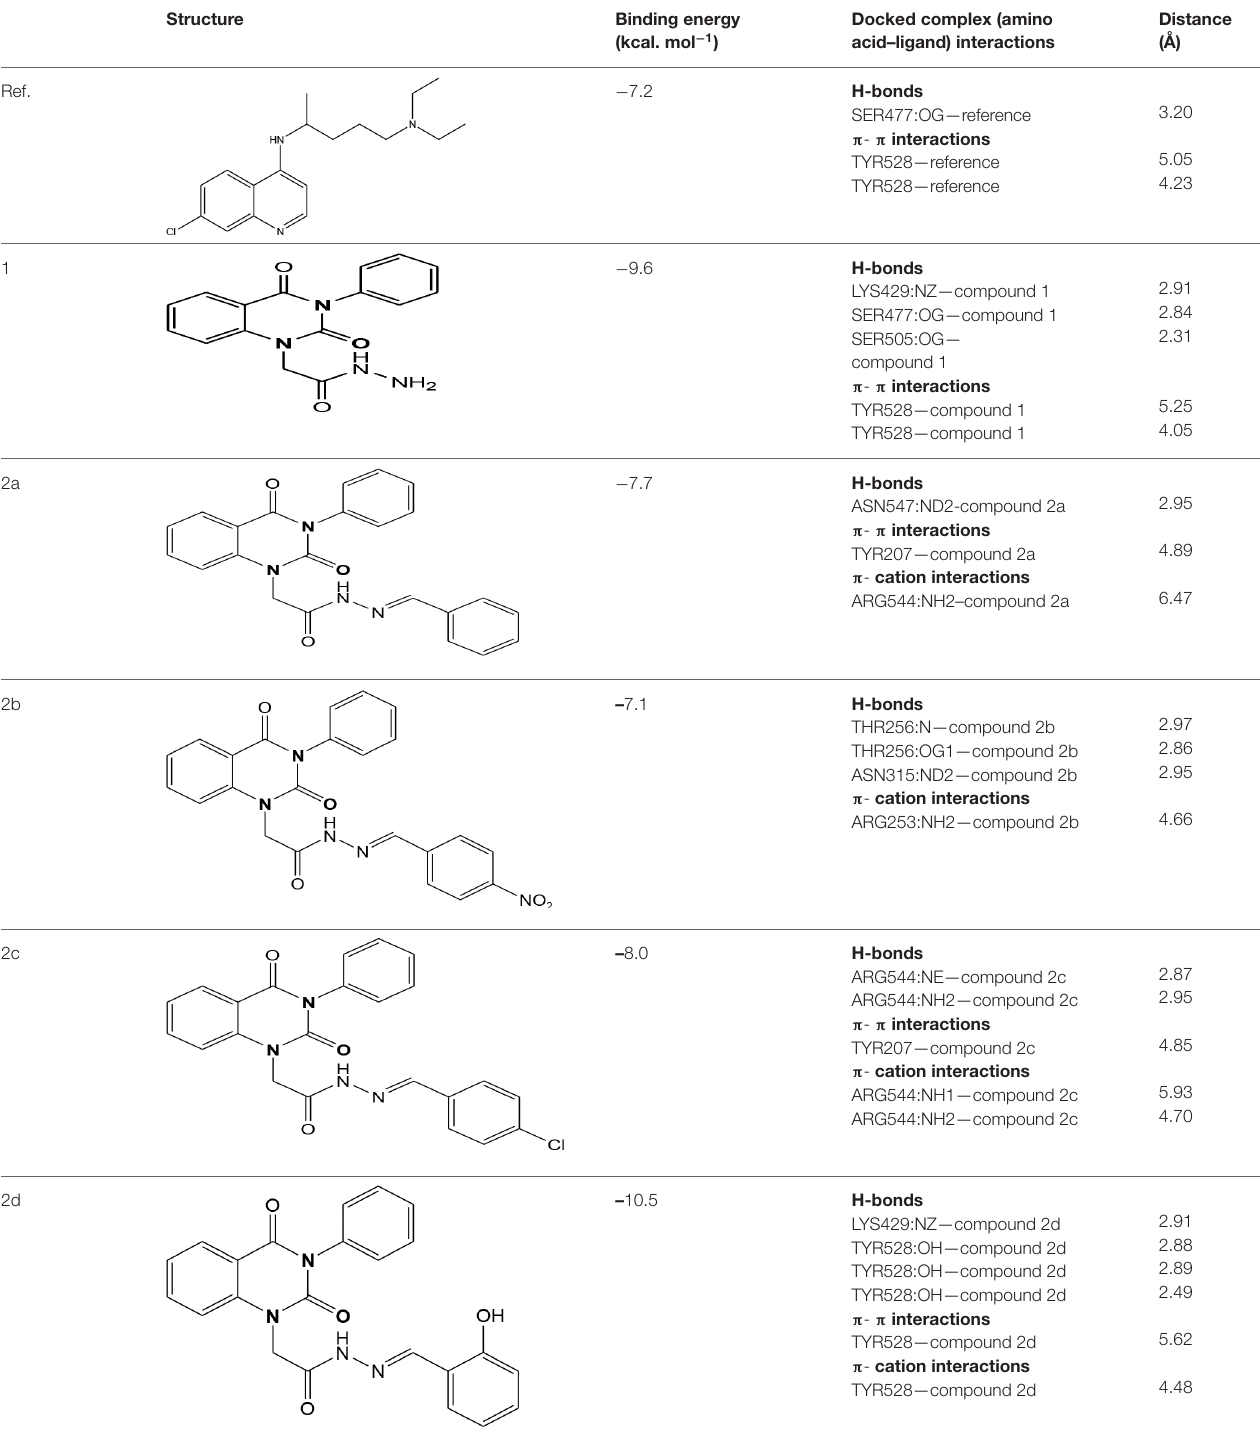
TABLE 1 | Docking results and types of interactions between the title compounds 1–16 and active site region of pf DHODH enzyme. Structure